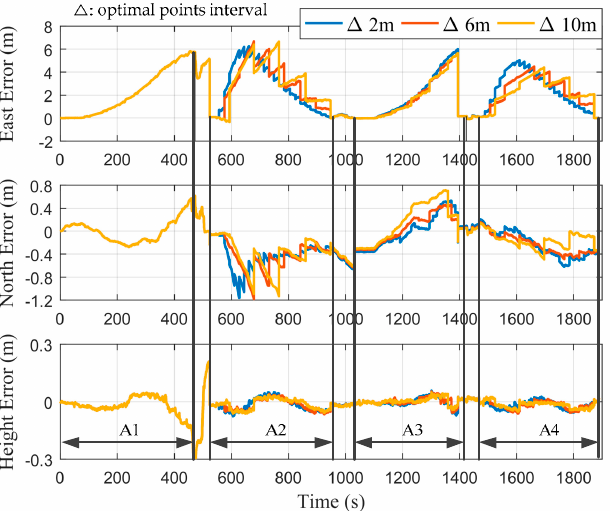
Figure 7. Positioning errors without performing RTS smoothing under different values of Δ .